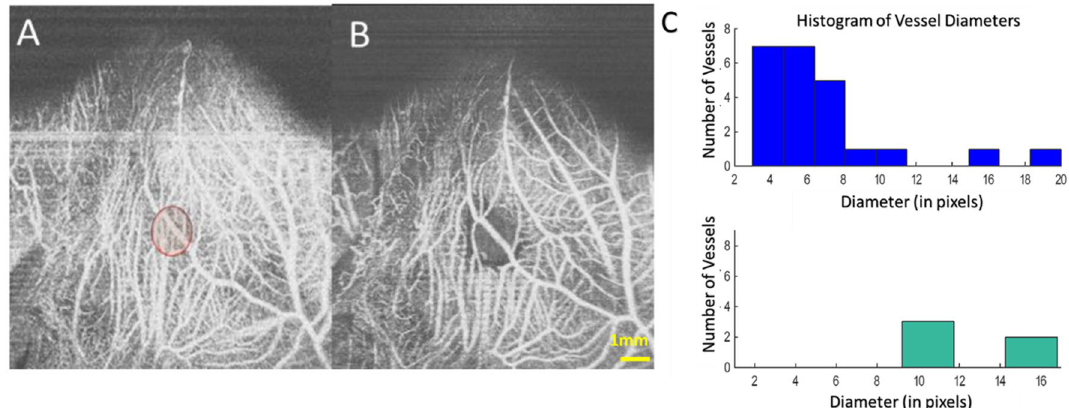
Figure 2. Coagulation of a CAM vasculature showing flow intact in the larger diameter vessels compared to the smaller microvasculature. Histogram analysis of blood vessel size distribution showing hemostasis only occurred in smaller vessels (right). Laser dosimetry: 7.7 J, 25 ms. Spot size 3 mm. Scale Bar is 1 mm. In the 512 × 512 enface image, each pixel corresponds to approximately 20 µm.